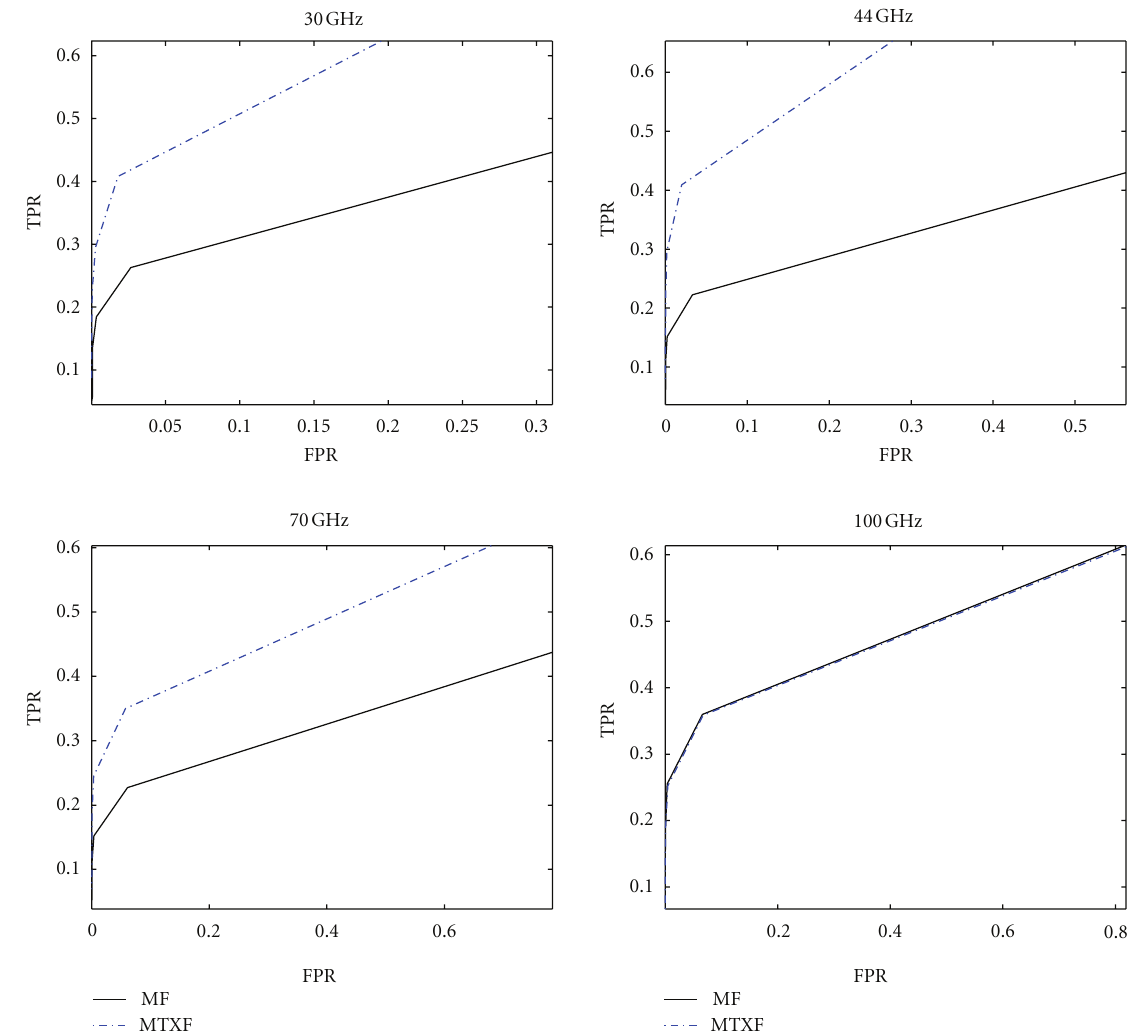
Figure 2: ROC curves for the filtering schemes and the four channels, considered. Solid line: MF. dot-dashed line: matrix filters. Axis labels: TPR stands for true positives ratio (associated to the completeness of a catalogue), FPR stands for false positives ratio (associated to the purity of the catalogue, a low FPR indicates a high